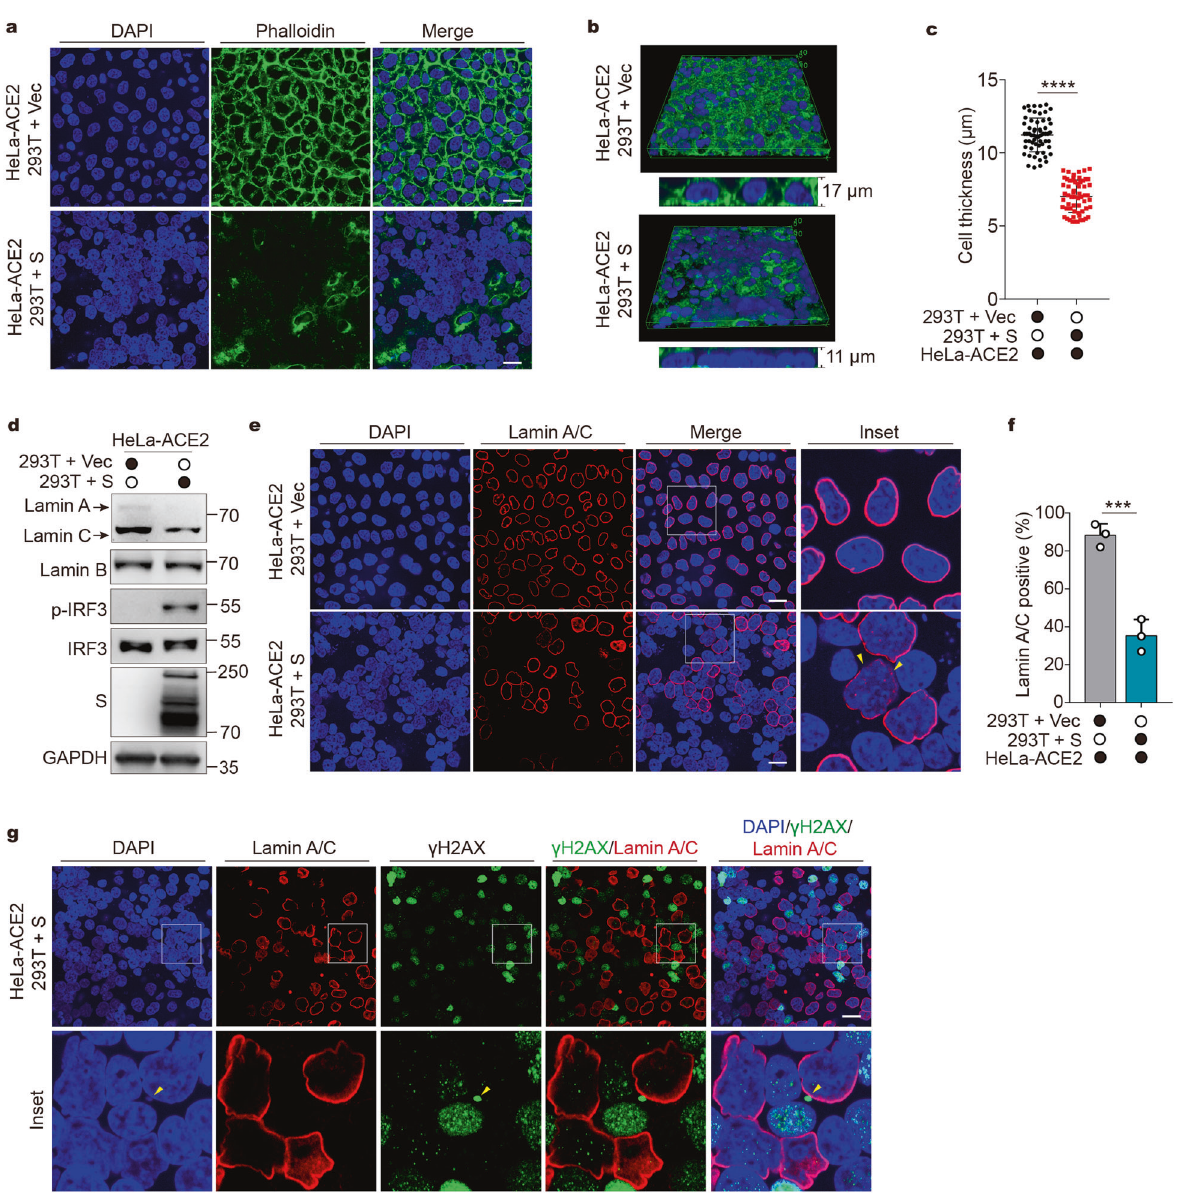
Fig. 5 Syncytia formation disrupts actin cytoskeleton and nucleoskeleton. a Representative fl uorescence images of co-culture experiment. HEK293T cells were transfected with vector control (Vec) or plasmids expressing spike (S) for 24 h. Cells were then detached and mixed with HeLa-ACE2. After 4.5 h, cells were stained with DAPI (blue) and fl uorescently labeled phalloidin (green) as indicated. Scale bar, 20 μ m. b Three- dimensional reconstructed images of a were displayed as volume view. c Quanti fi cation of cell thickness. Cells were measured for height based on z-stack images. Mean ± s.d. Data were pooled from 3 independent experiments. **** P < 0.0001, two-tailed Student ’ s t -test. d Cells were treated as described in a and subjected to Western blot analysis using indicated antibodies. e Cells were treated as described in a and stained with DAPI (blue) and anti-lamin A/C antibody (red) as indicated. Scale bar, 20 μ m. f Quanti fi cation of Lamin A/C positive cells from experiments described in e . Mean ± s.d., n = 3 independent experiments. *** P < 0.001. Two-tailed Student ’ s t -test. g HEK293T cells were transfected with plasmids expressing S for 24 h. Cells were then detached and mixed with HeLa-ACE2. After 4.5 h, cells were stained with DAPI (blue), anti- γ H2AX (green) antibody, and anti- Lamin A/C antibody (red) as indicated. Scale bar, 20 μ